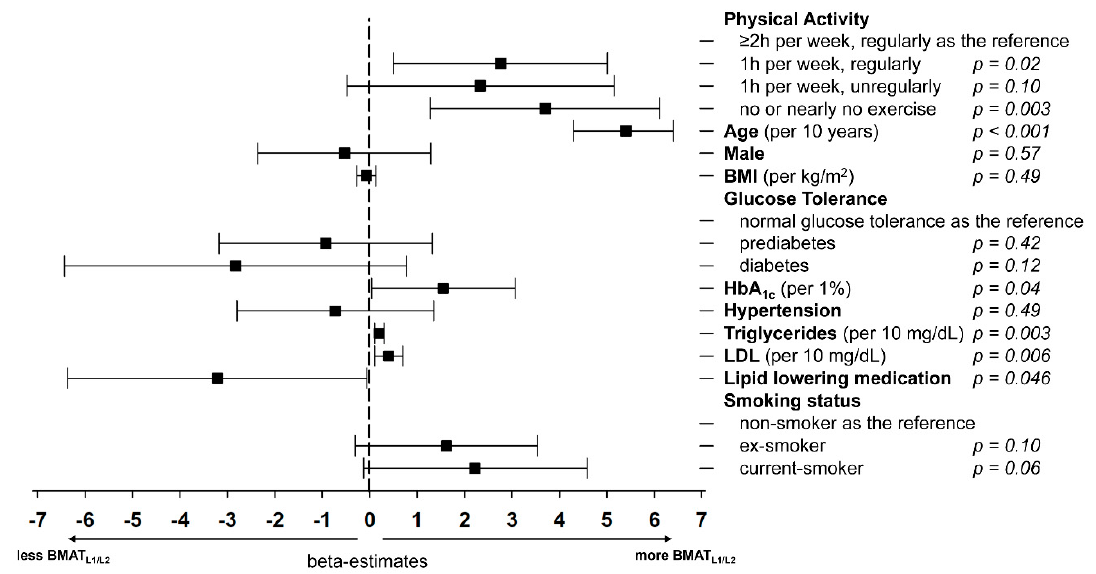
Figure 2. Forrest-plot demonstrating the multivariate association of demographics and risk factors with vertebral bone marrow adipose tissue (BMATL1 / L2). BMI denotes body-mass-index; HbA1c, hemoglobin A1c; LDL, low-density lipoprotein. Table 2. Univariate and multivariate associations of vertebral bone marrow adipose tissue (BMAT L1 / L2 ) with visceral adipose tissue (VAT) and subcutaneous adipose tissue (SAT). The simple model included age, sex, and physical activity, whereas the fully adjusted model included age, sex, physical activity, diabetes status, hypertension, triglyceride, LDL-cholesterol, and lipid lowering medication.